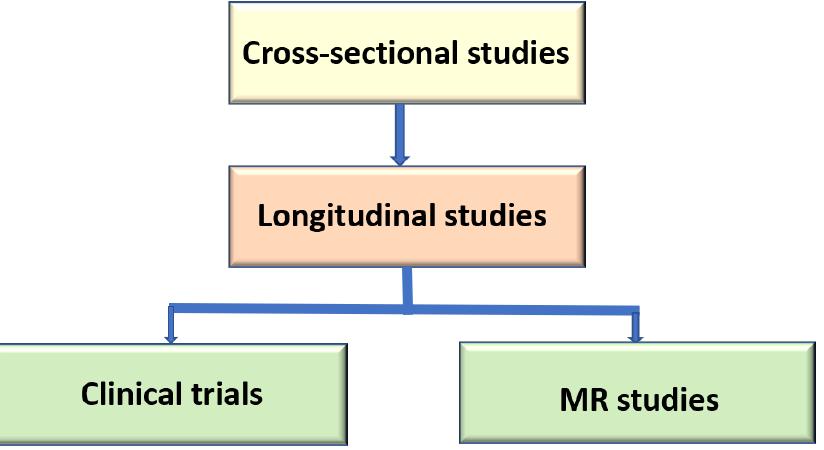
Figure 2. Different types of studies for the identification of risk factors for type 2 diabetes and cardiovascular diseases (MR, Mendelian randomization study).